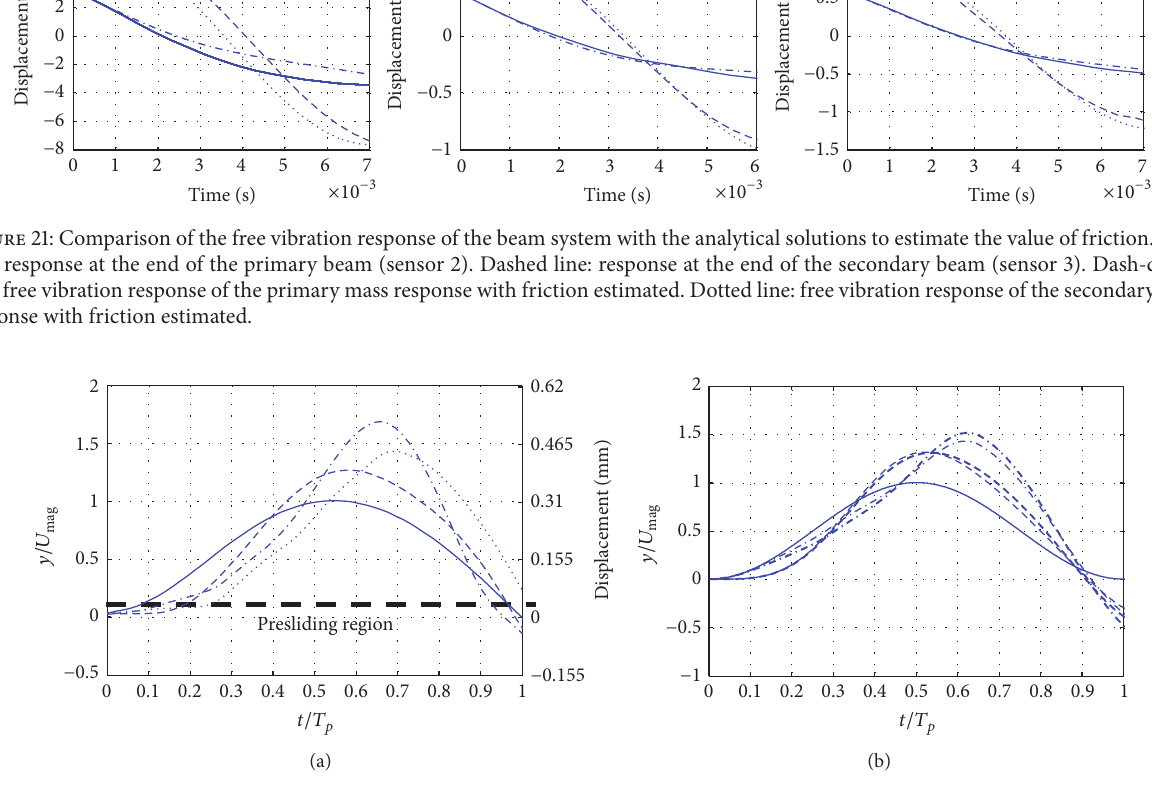
Figure 22: Displacement response of the thin secondary beam system with intermediate friction. (a) Measured. Solid line: base input. Dashed line: response at the end of the primary beam (sensor 2). Dash-dotted line: response at the end of the secondary beam (sensor 3). Dotted line: response at the end of the secondary beam (sensor 4). (b) Simulation with intermediate Coulomb friction. Solid line: base input. Dashed ̂𝐹 = 0.39 ̂𝐹 = 0.48 thick line: primary mass response, . Dashed thin line: primary mass response, . Dash-dotted thick line: secondary mass ̂𝐹 = 0.39 ̂𝐹 = 0.48 response, . Dash-dotted thin line: secondary mass response,